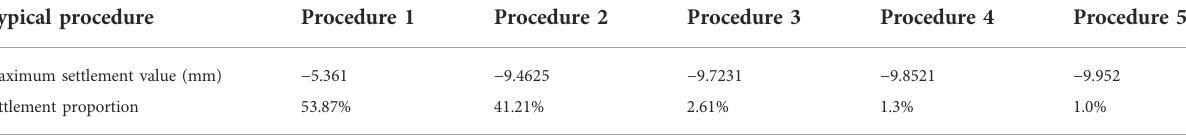
TABLE 7 Statistic value of ground surface settlement of monitoring Section 2.